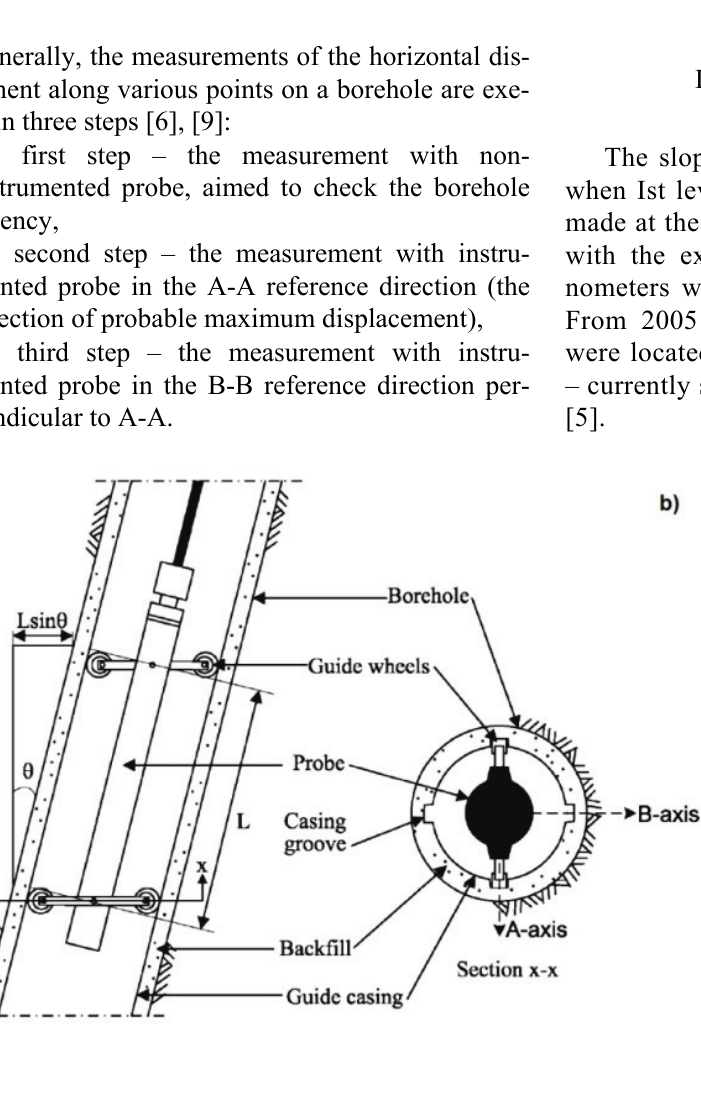
Fig. 3. Schematic of the slope inclinometer: (a) inclinometer device, (b) illustration of operation (based on [6],